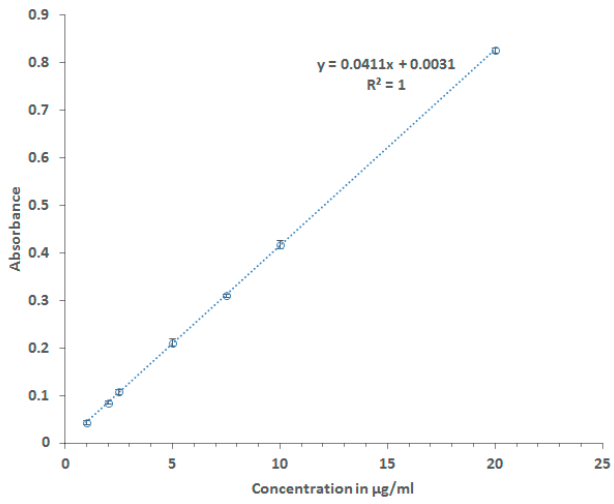
Figure 1. Bendrofluromethiazide Calibration Curve.